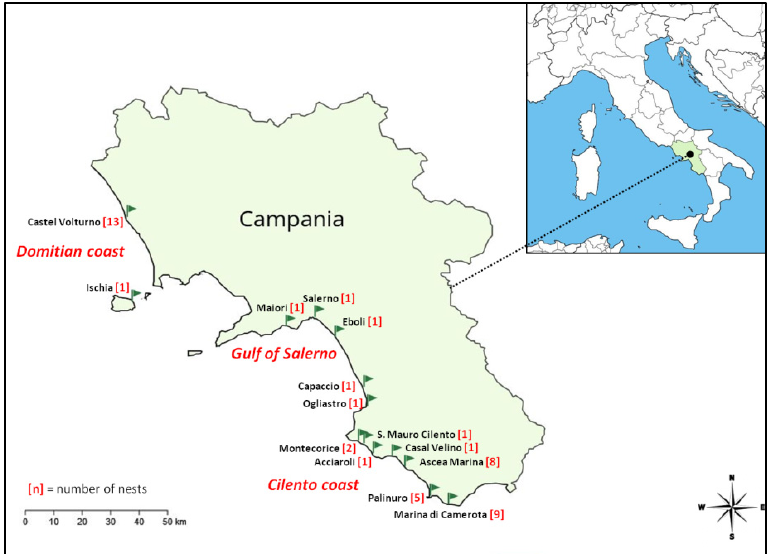
Figure 1. Map showing the geographical locations of sites in the Campania region, southern Italy, where nests were sampled.